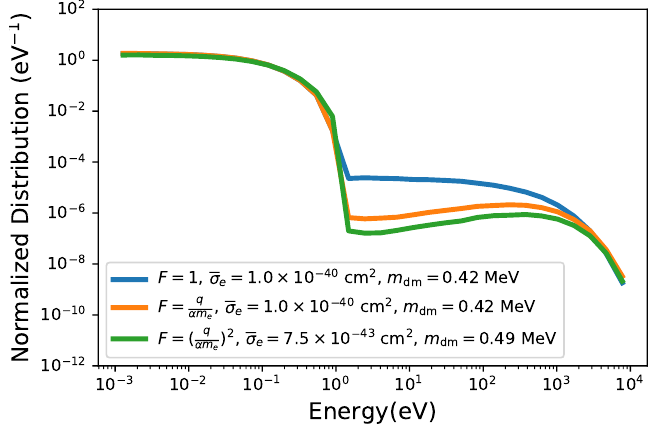
Figure 1 . Normalized energy distributions of the heated DM fluxes on the Earth for parameters given in eq. (3.3), for F = 1 , F = q